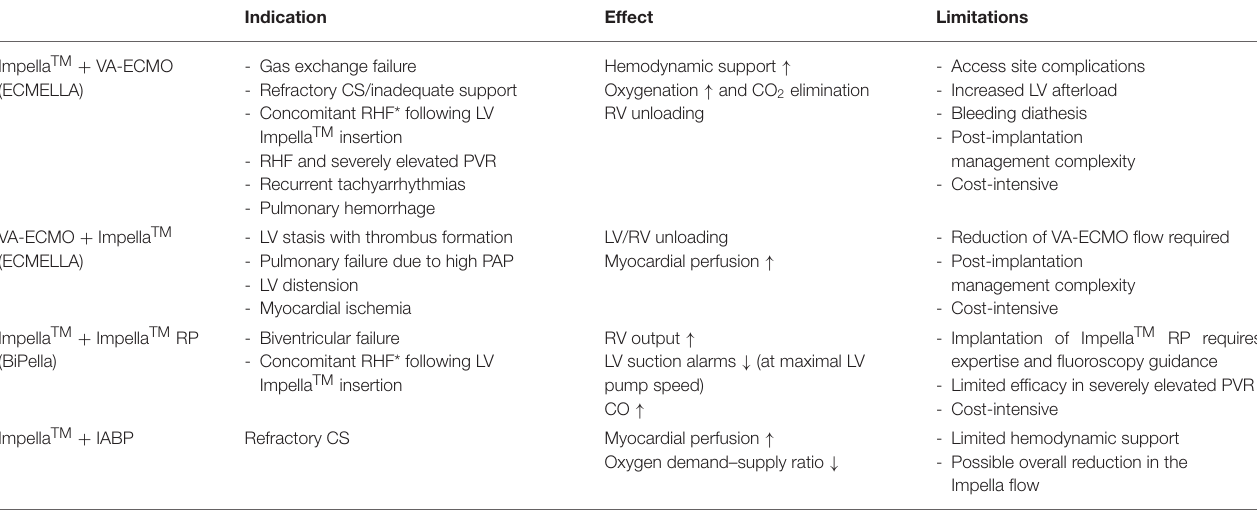
TABLE 6 | Combination of Impella TM with other